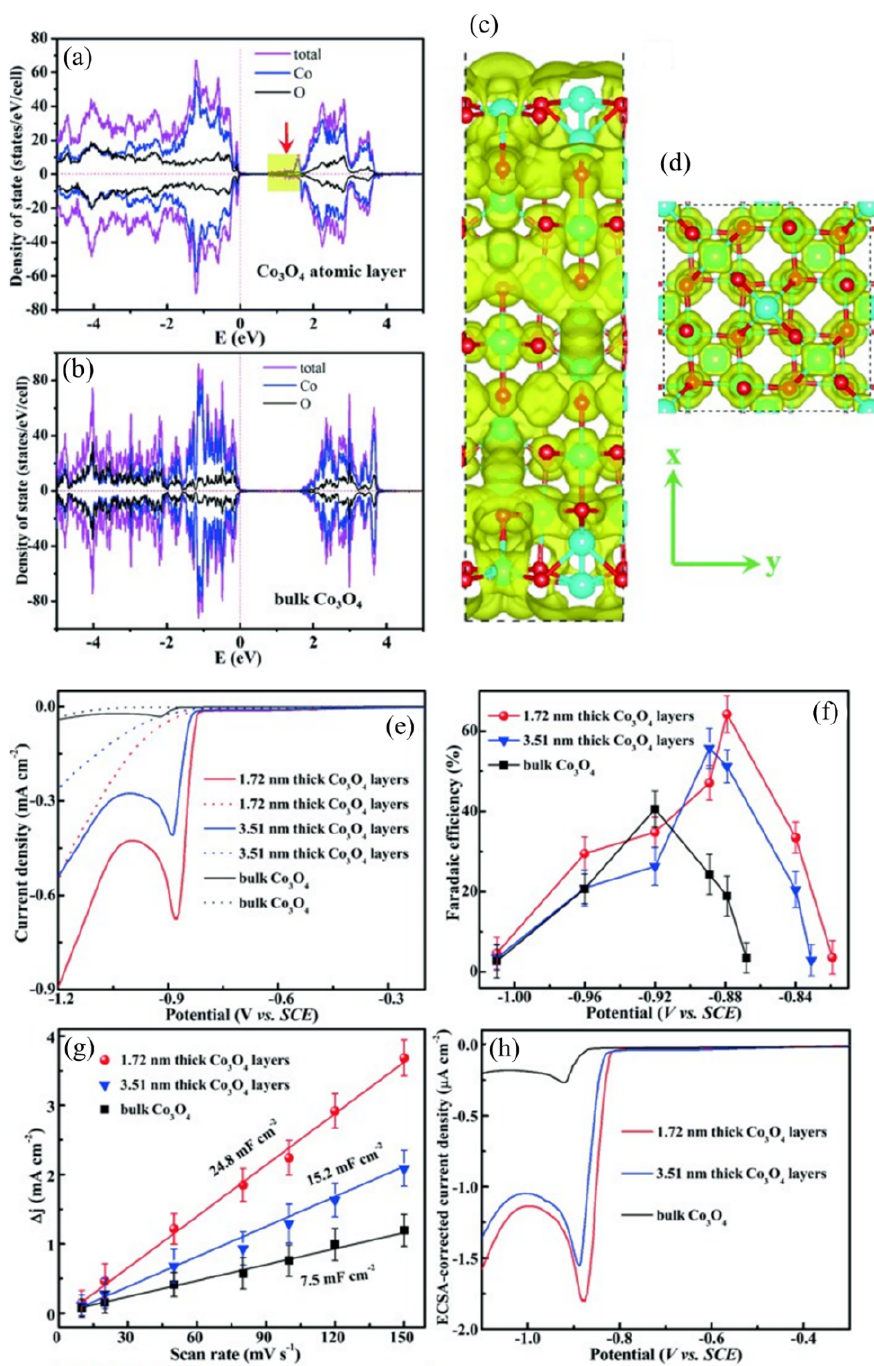
Figure 7. The calculated DOS for ( a ) Co 3 O 4 atomic layer slab with a thickness of 1.72 nm and ( b ) bulk Co 3 O 4 slab. The yellow shaded parts represent the increased DOS at the conduction band edges of Co 3 O 4 atomic layer. The partial charge density around the conduction band minimum of ( c ) Co 3 O 4 atomic layer slab and ( d ) bulk Co 3 O 4 slab, in which yellow refers to charge density contour with the isovalue of 0.0001 e/bohr 3 . Cyan represents Co and red represents O atoms. Electroreduction of CO 2 to formate by Co 3 O 4 with different thicknesses: ( e ) LSV curves in the CO 2 -saturated (solid line) and N 2 -saturated (dashed line) 0.1 M KHCO 3 aqueous solutions. ( f ) Faradaic efficiencies for formate at each applied potential for 4 h. ( g ) Charging current density differences plotted against scan rates.